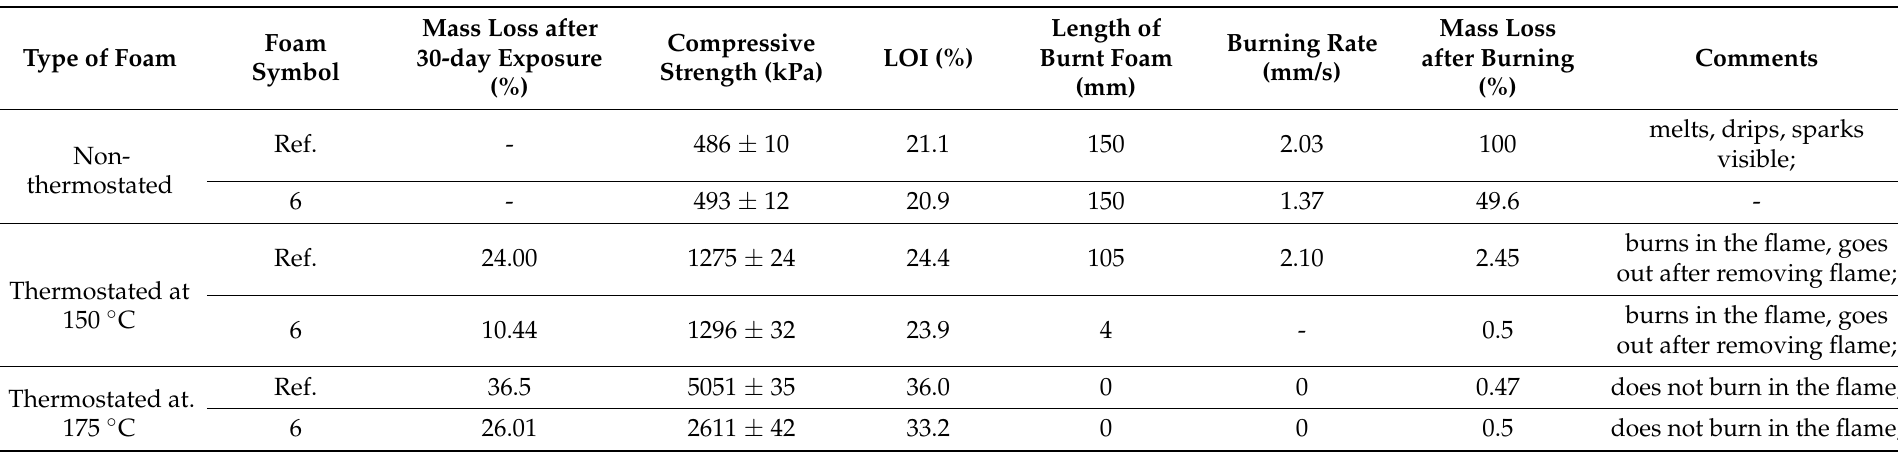
Table 6. Comparison of the fire properties of the reference foam and the foam obtained from a mixture of polyols before and after temperature